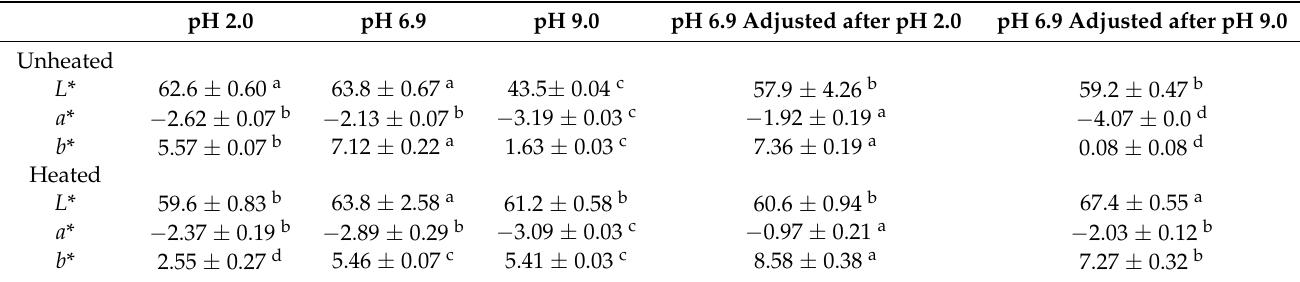
Table 1. Color chromaticity coordinates of unheated and heated (90 ◦ C × 20 min) soy protein isolate dispersions at pH 2.0, pH 6.9, and pH 9.0 and dispersions readjusted from pH 9.0 and pH 2.0 back to pH